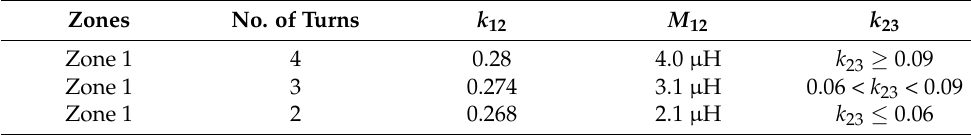
Table 2. k 12 , M 12 and k 23 in three operating zones.